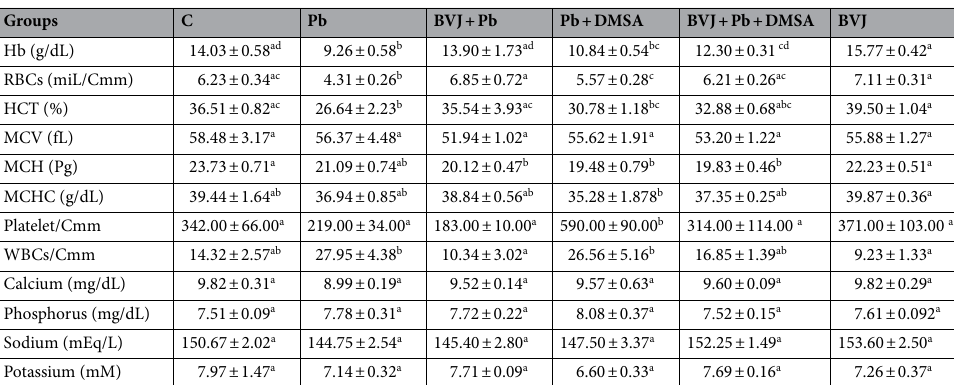
Table 2. The changes in the hematological parameters and levels of serum electrolytes in all the studied groups. Hb hemoglobin, RBCs red blood cells, HCT hematocrit "volume of RBCs in blood", MCV mean corpuscular volume "average volume of RBCs", MCH mean corpuscular Hb "average mass of Hb/RBCs", MCHC mean corpuscular Hb concentration "concentration of Hb in a given volume of RBCs", WBCs white blood cells. Results are expressed as mean ± SE (n = 5). Different letters are significantly different for the same row at P < 0.05.